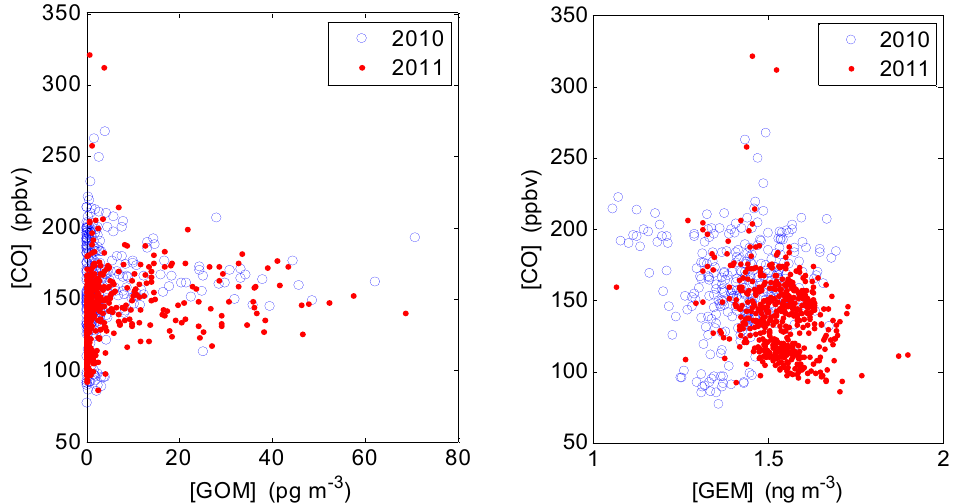
Figure 8. Correlation between CO and GOM ( Left ) and between CO and GEM ( Right ) during the summer 2010 intensive (blue circles) and the spring 2011 intensive (red